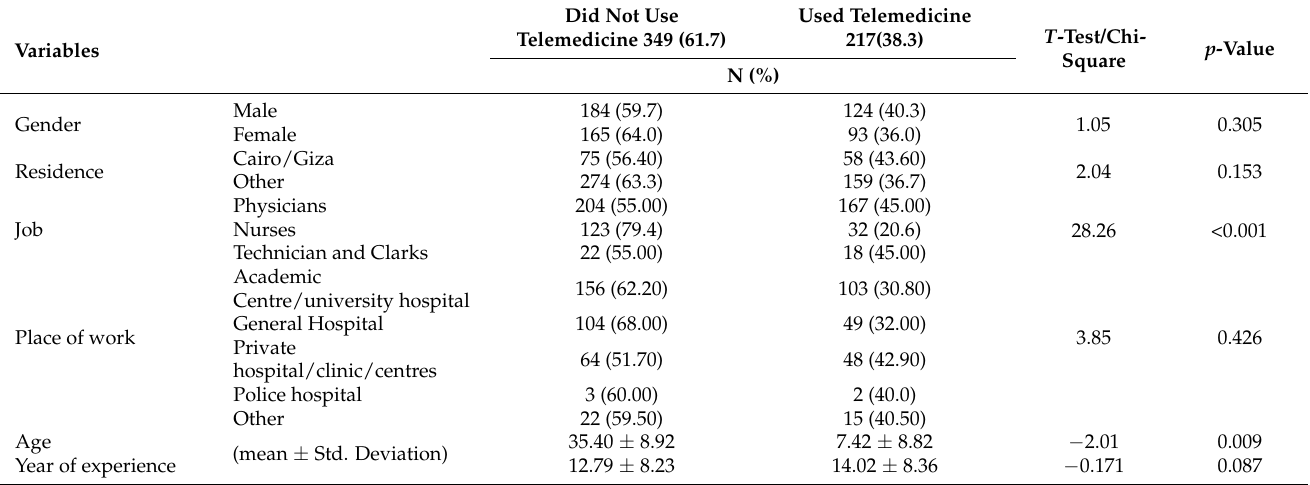
Table 2. Association between the different sociodemographic variables and telemedicine use.